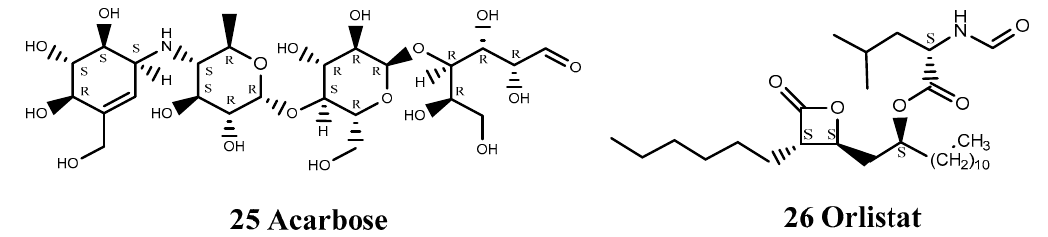
Figure 7. Structures of antidiabetic and anti-obesity drugs.